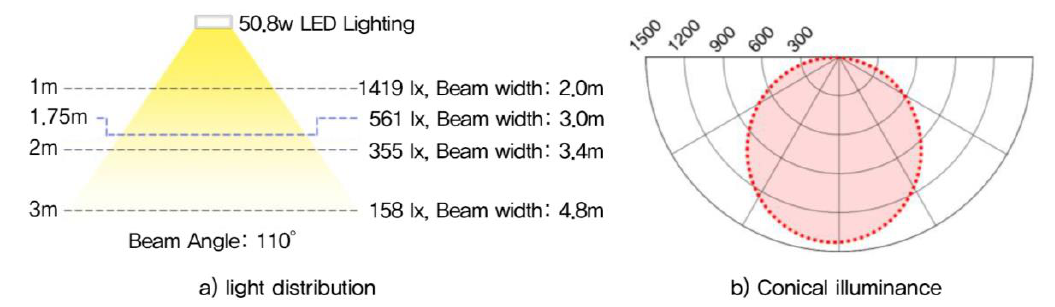
Figure 4. Light distribution and conical illuminance and of lighting.